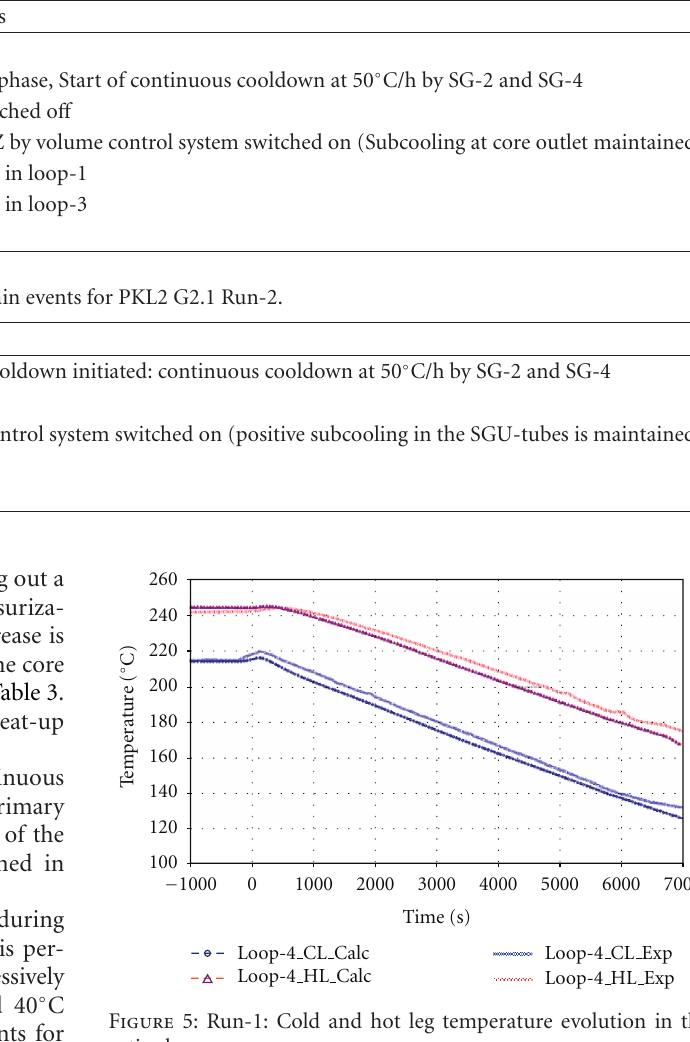
Table 3: Main events for PKL2 G2.1 Run-1.